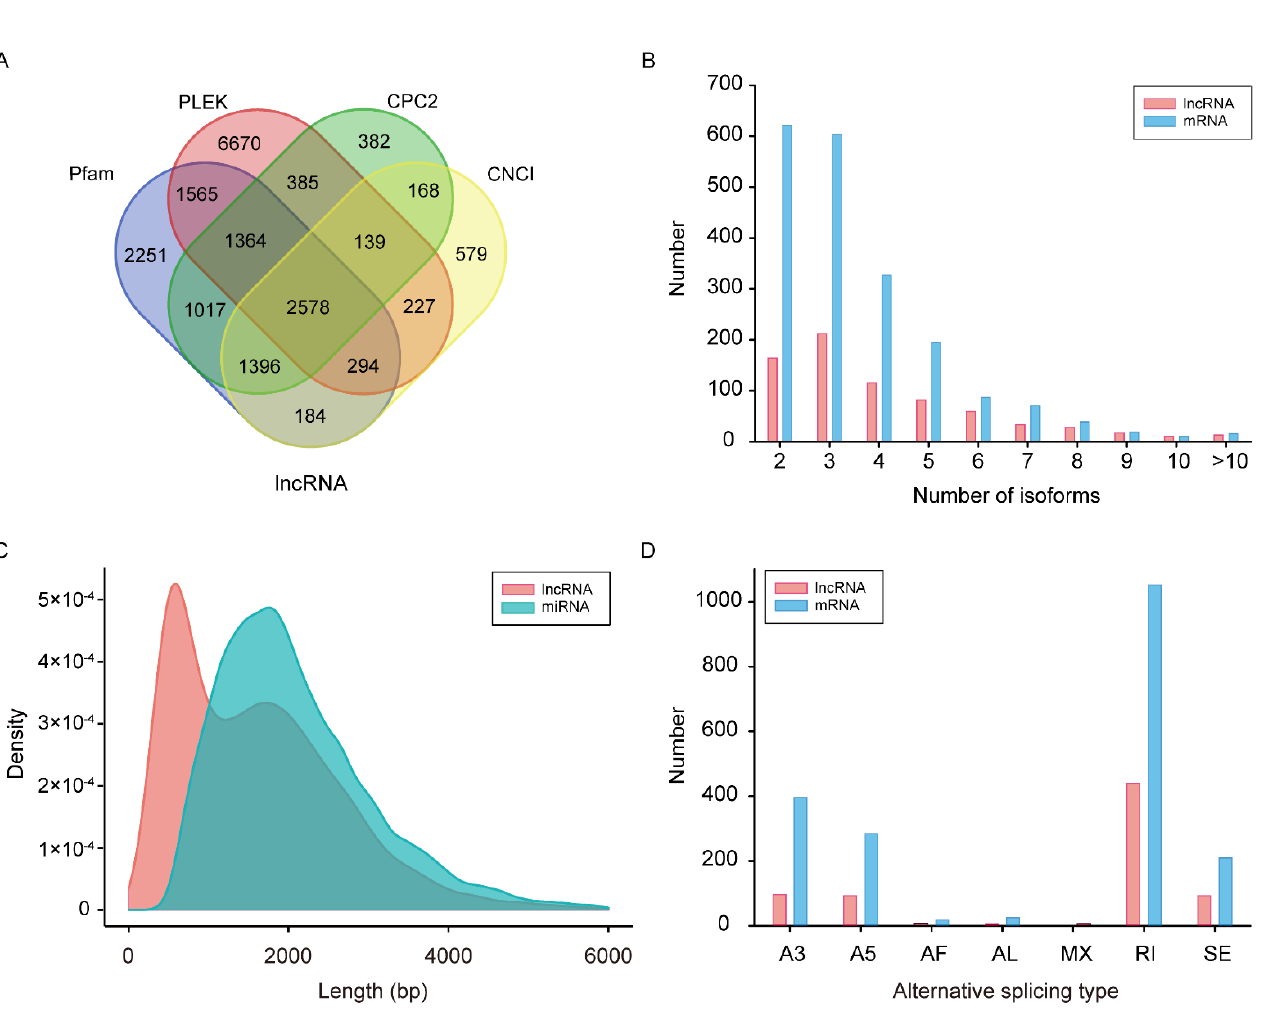
Figure 4. Distribution and features of lncRNA. ( A ) Venn diagram of predicted lncRNAs. ( B ) Distri- bution of isoform numbers of lncRNA and mRNA. ( C ) Density distribution of lncRNA and mRNA length. ( D ) Distribution of AS events of lncRNA and mRNA.